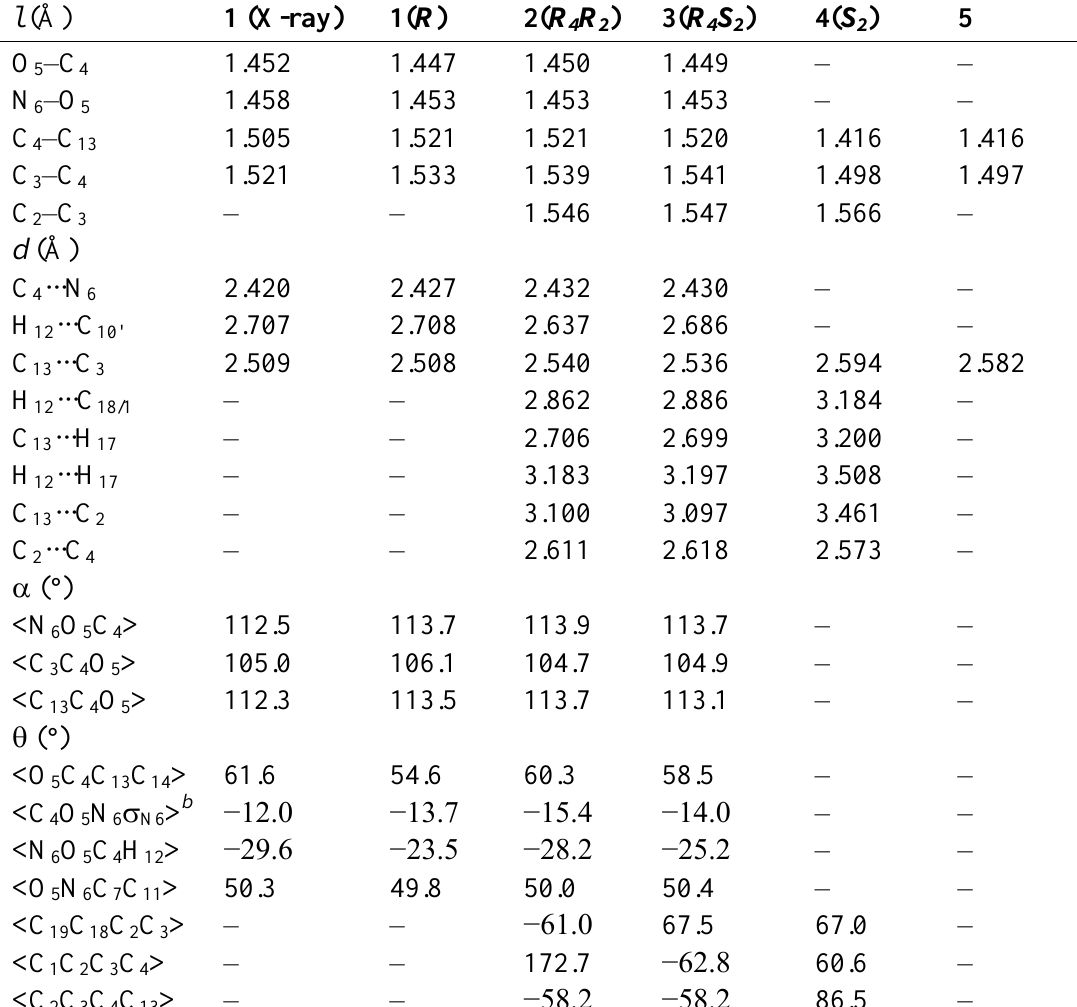
calculated by DFT at f